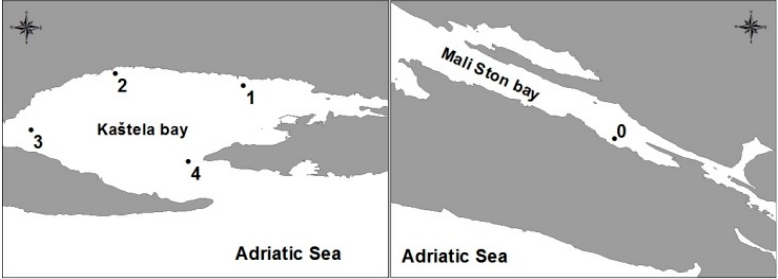
Figure 1. Kaštela Bay and Mali Ston Bay—the studied stations.